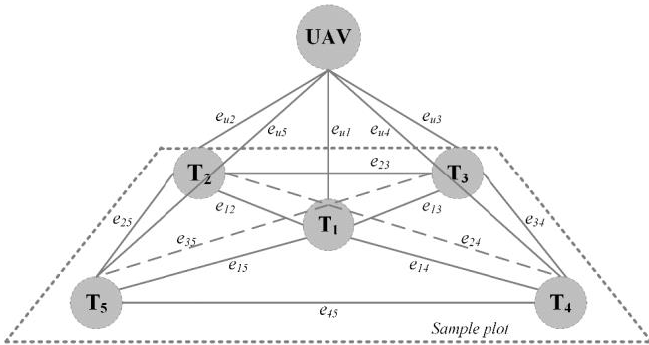
Figure 3. Graph of the global adjustment framework. Five scans (T 1 –T 5 ) in a 30 m × 30 m sample plot are illustrated as an example, in which T 1 is placed at the center of the plot and T 2 –T 5 are placed at the four corners.